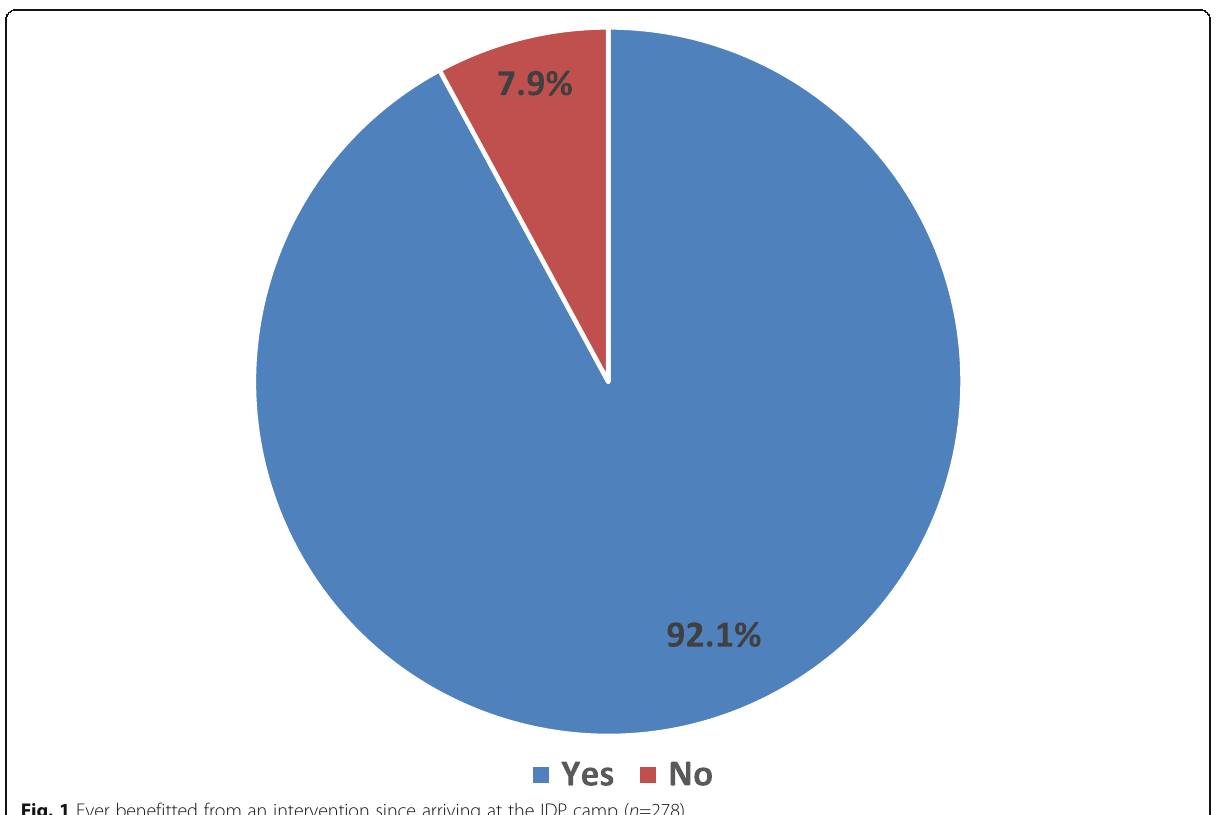
Fig. 1 Ever benefitted from an intervention since arriving at the IDP camp ( n =278)